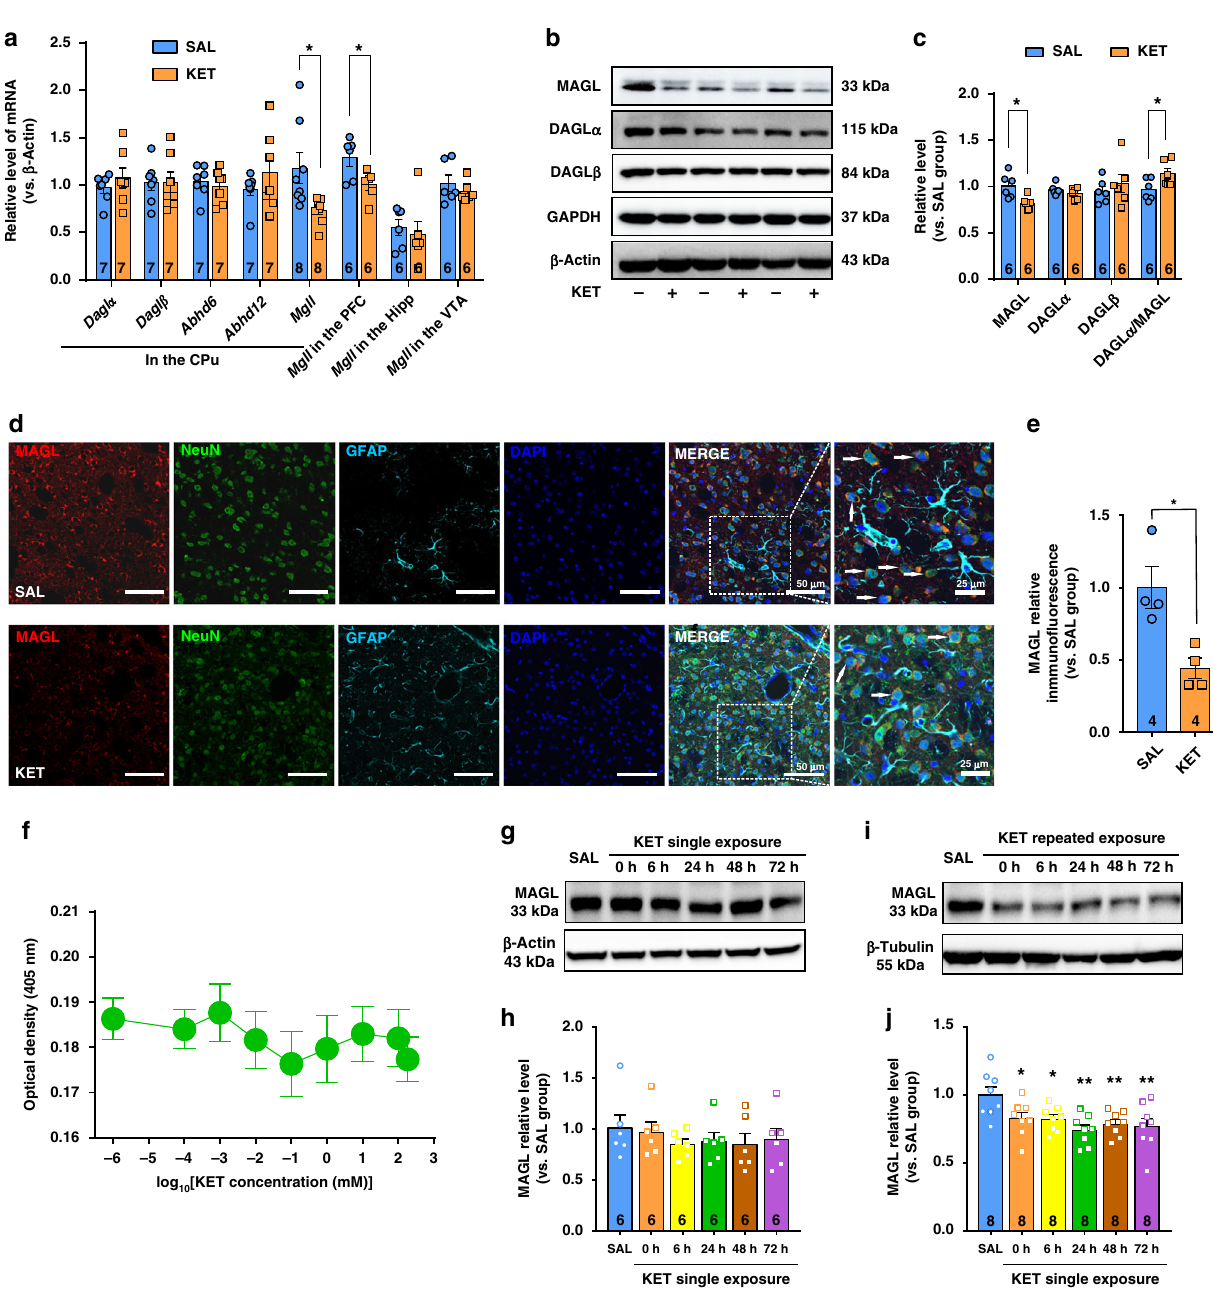
Fig. 4 Ketamine represses MAGL transcription in the CPu, leading to an increase in 2-AG production. a Ketamine (15 mg/kg) decreased mRNA expression of MAGL gene in the CPu and PFC (Unpaired t test, Mgll in the CPu, t (14) = 2.674, P = 0.0182; Mgll in the PFC, t (10) = 2.647, P = 0.0244). b Representative immunoblotting for the expression of 2-AG metabolic enzymes in the dorsal striatum. c Ketamine (15 mg/kg) decreased MAGL protein expression and increased the ratio of DAGL α to MAGL (DAGL α /MAGL) in the CPu (Unpaired two-tailed t test: MAGL, t (10) = 3.069, P = 0.0119; DAGL α / MAGL, t (10) = − 2.324, P < 0.05). d Co-immunostaining for MAGL (red), NeuN (green), GFAP (wathet blue), and DAPI (deep blue) in the DLS. Arrows indicate the neurons positive for MAGL. e Ketamine (15 mg/kg) reduced MAGL expression in the DLS neurons (unpaired two-tailed t test, t (6) = 3.486, P = 0.0131). f Ketamine did not affect MAGL enzyme activity in vitro. n = 3 samples/group. g , h MAGL expression was not altered by a single ketamine (15 mg/kg). i , j MAGL expression decreased within 72 h after repeated exposure to ketamine (15 mg/kg; one-way ANOVA, followed by Dunnett ’ s multiple comparisons test, F (5,42) = 3.922, P = 0.0052; 0 h vs. SAL, P = 0.049; 6 h vs. SAL, P = 0.0404; 24 h vs. SAL, P = 0.0014; 48 h vs. SAL, P = 0.0099; 72 h vs. SAL, P = 0.0048). Data are shown as mean ± SEM. Compared to SAL group, * P < 0.05, ** P < 0.01. CPu caudate nucleus and putamen, PFC prefrontal cortex, Hipp hippocampus, VTA ventral tegmental area, SAL saline, KET ketamine. Source data provided as a Source Data fi